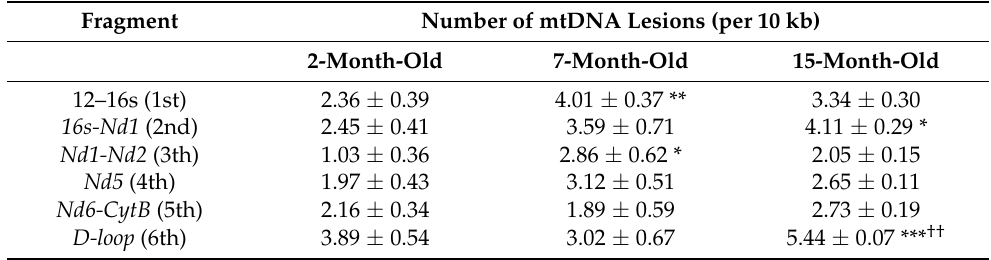
Table 1. Number of mtDNA lesions in the cerebral cortex in the three age groups of mice. Fragment